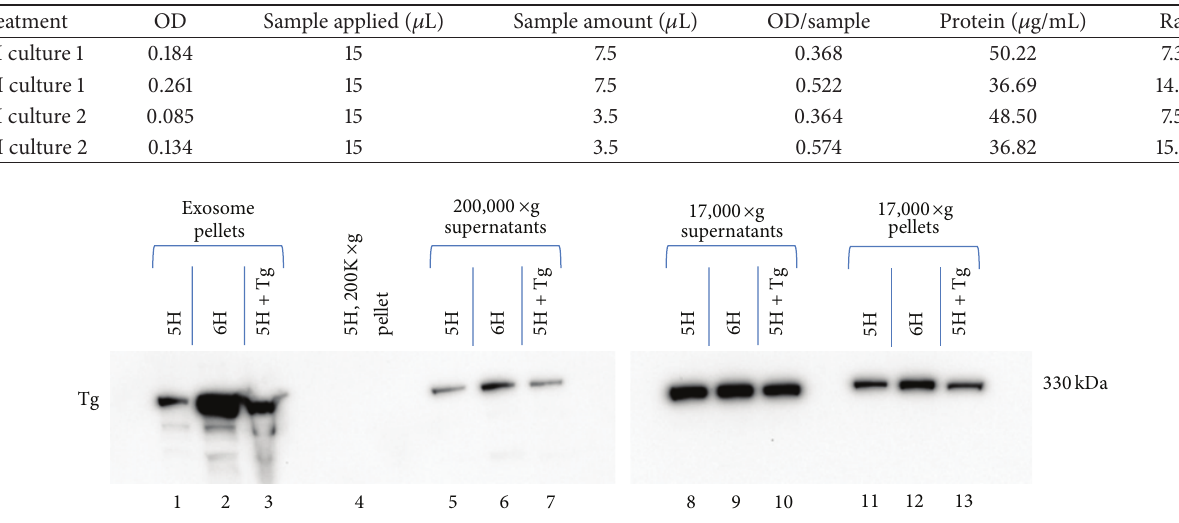
Figure 5: SDS-PAGE and Tg Western blot of samples from different stages of exosome isolation by ultracentrifugation: 17,000 × g pellet and supernatant, 200,000 × g supernatant, and 200,000 × g (exosome pellet) from samples of 5H medium (lanes 1, 5, 8, and 11), 6H medium (lanes 2, 6, 9, and 12), and 5H medium with 1mg/mL Tg (lanes 3, 7, 10, and 13) from confluent cultures of FRTL-5 cells incubated for 48 hours. Additionally, lane 4 contains a sample of the 200,000 × g pellet obtained from fresh 5H media (i.e., unexposed to FRTL-5 cells). Western blots were treated with a monoclonal anti-human-Tg antibody and developed using SuperSignal West Pico. “Exosome pellets” = 200,000 × g